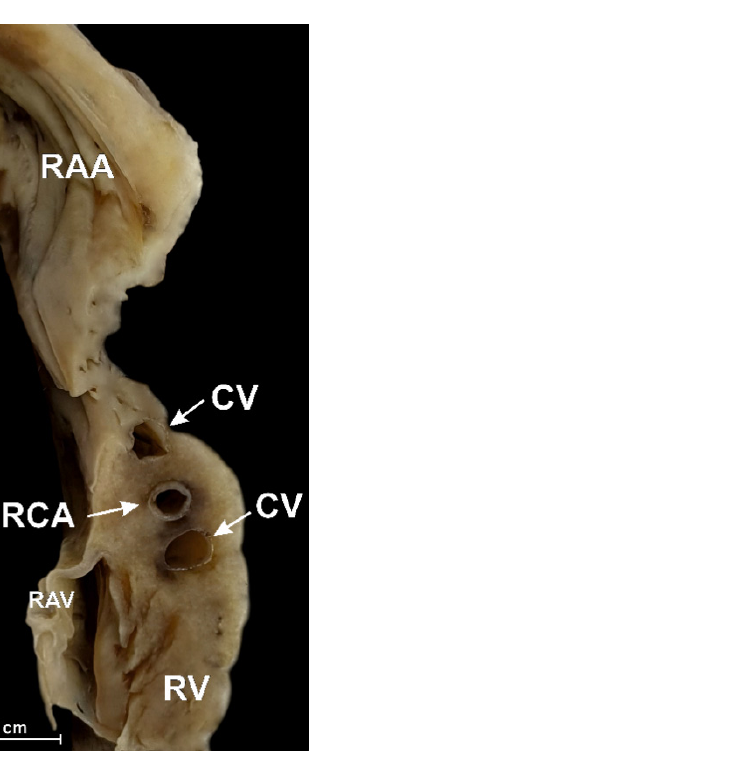
Figure 4. Photograph of a cadaveric heart specimen showing the longitudinal section through the inferior right atrial appendage (RAA) isthmus with right coronary artery (RCA) accompanied by two coronary veins (CV). RAV—right atrio-ventricular valve, RV—right ventricle.